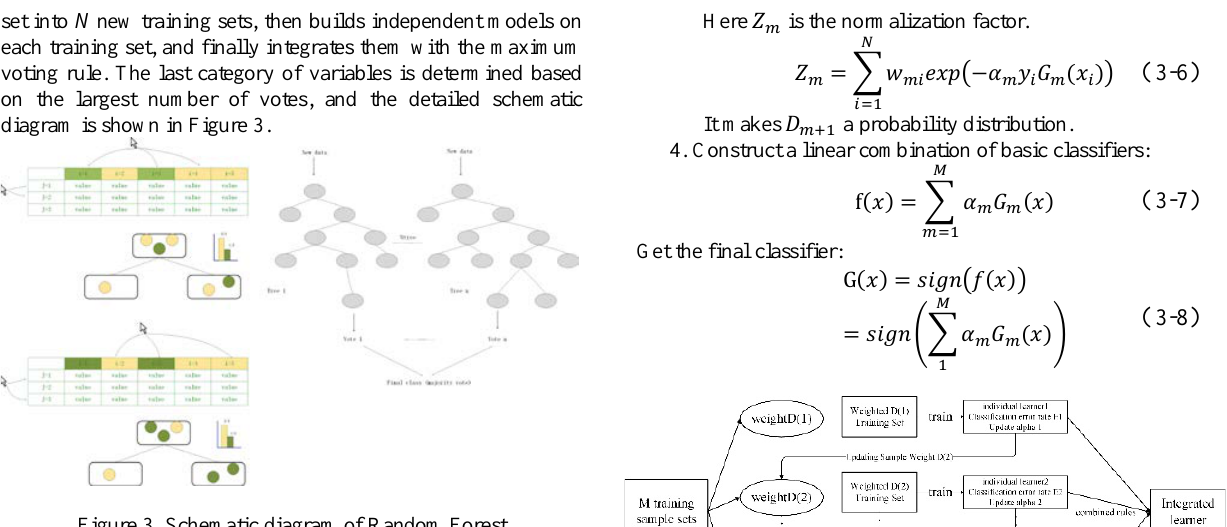
Figure 3. Schematic diagram of Random Forest